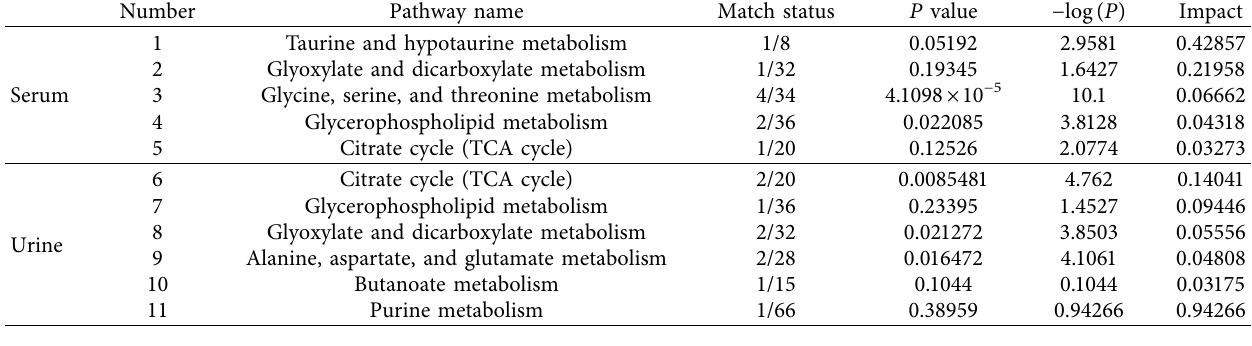
Figure 7: (a) Summary of metabolic pathway analysis of potential metabolites in serum samples. (1) Taurine and hypotaurine metabolism. (2) Glyoxylate and dicarboxylate metabolism. (3) Glycine, serine, and threonine metabolism. (4) Glycerophospholipid metabolism. (5) TCA cycle. (b) Summary of metabolic pathway analysis of potential metabolites in urine samples. (1) TCA cycle. (2) Glycerophospholipid metabolism. (3) Glyoxylate and dicarboxylate metabolism. (4) Alanine, aspartate, and glutamate metabolism. (5) Butanoate metabolism. (6) Purine metabolism. Table 3: Results of integrating enrichment analysis of biomarkers with MetaboAnalyst.